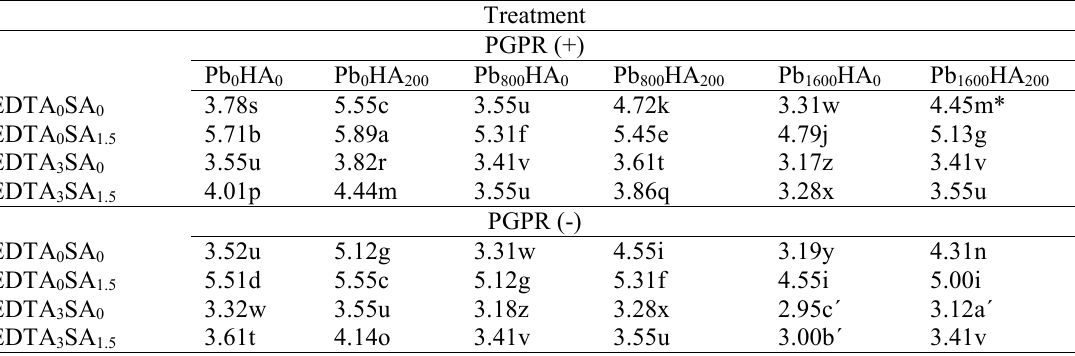
Table 3. Effect of treatments on plant biomass (g)